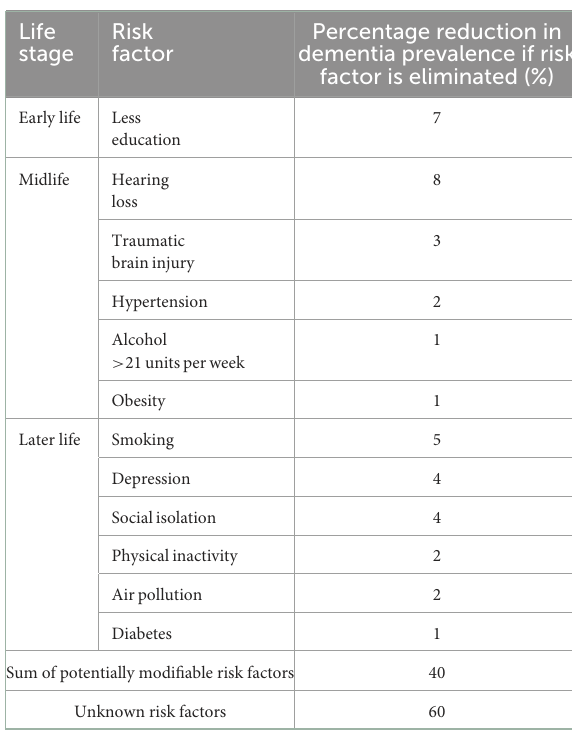
TABLE 1 Modifiable risk factors for dementia by life stage [adapted from Livingston et al.